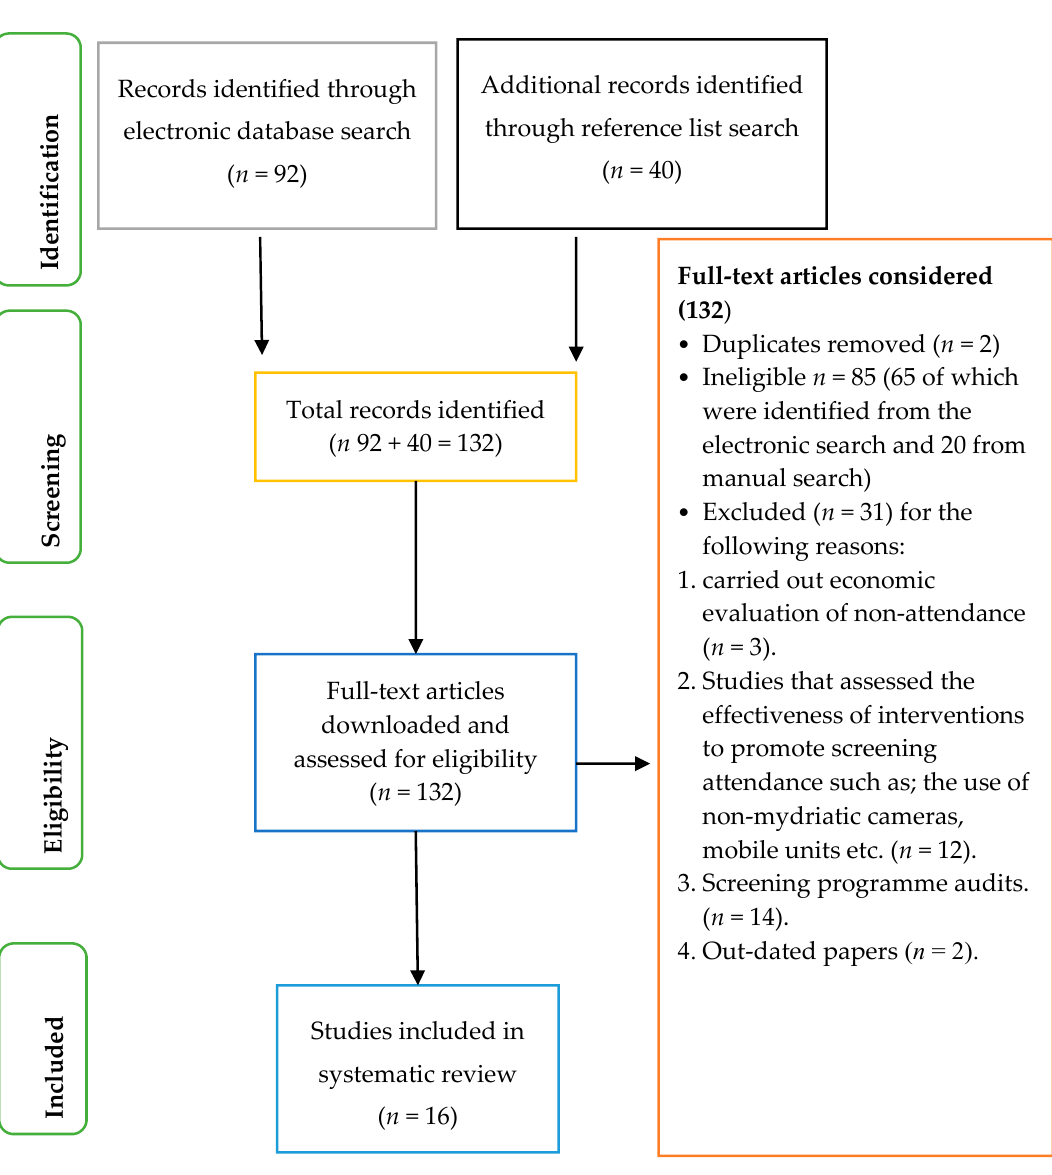
Figure 1. Flow chart showing the article selection process.